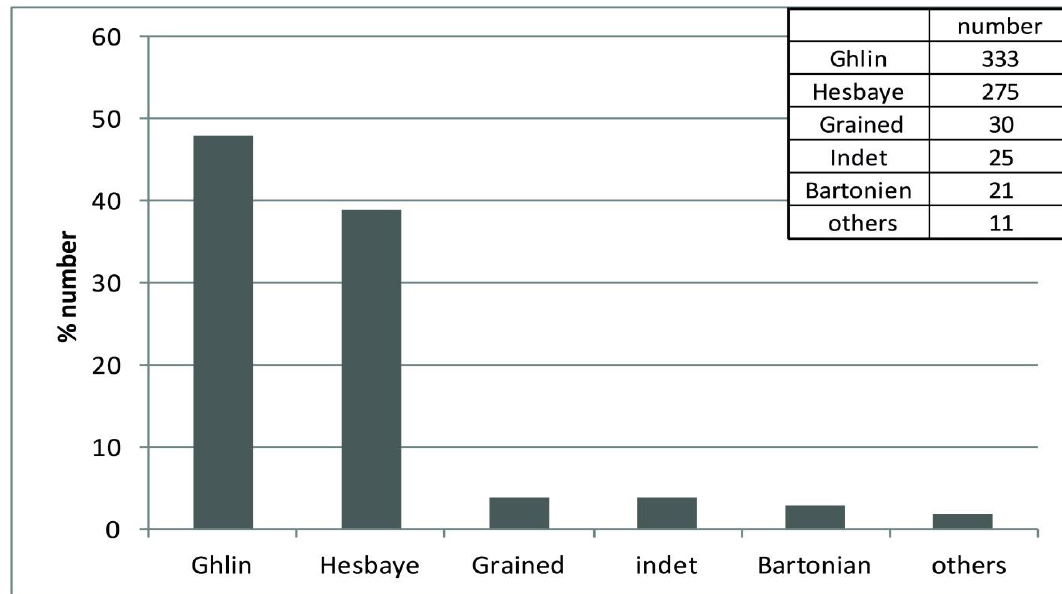
Figure 6. Laminar production. Count of the pieces attributed to the laminar production by raw